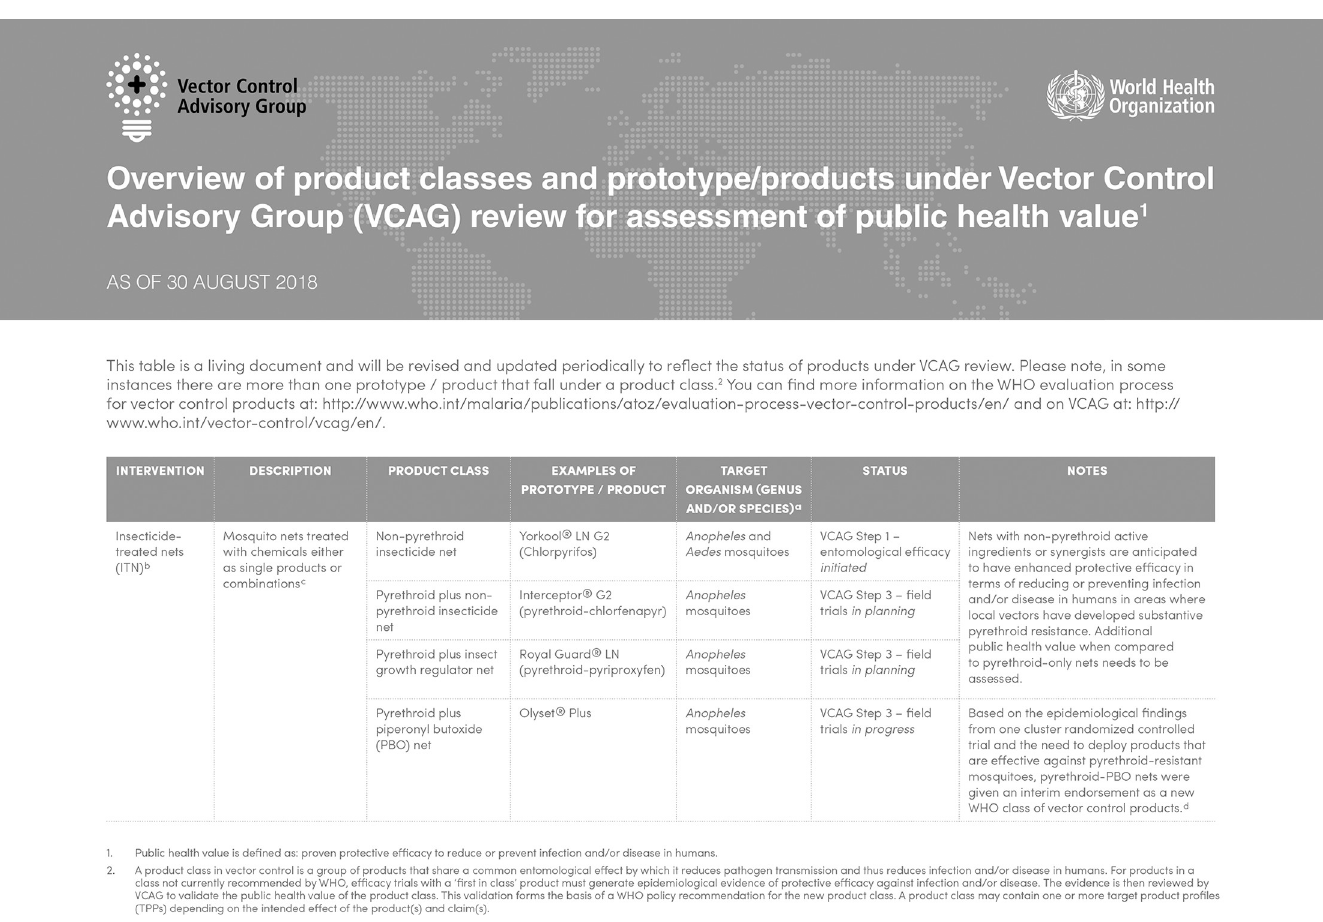
Fig 1. WHO VCAG overview of new vector control product classes and status of evaluation. Available from: http://apps.who.int/iris/bitstream/handle/10665/ 274451/WHO-CDS-VCAG-2018.03-eng.pdf?ua=.